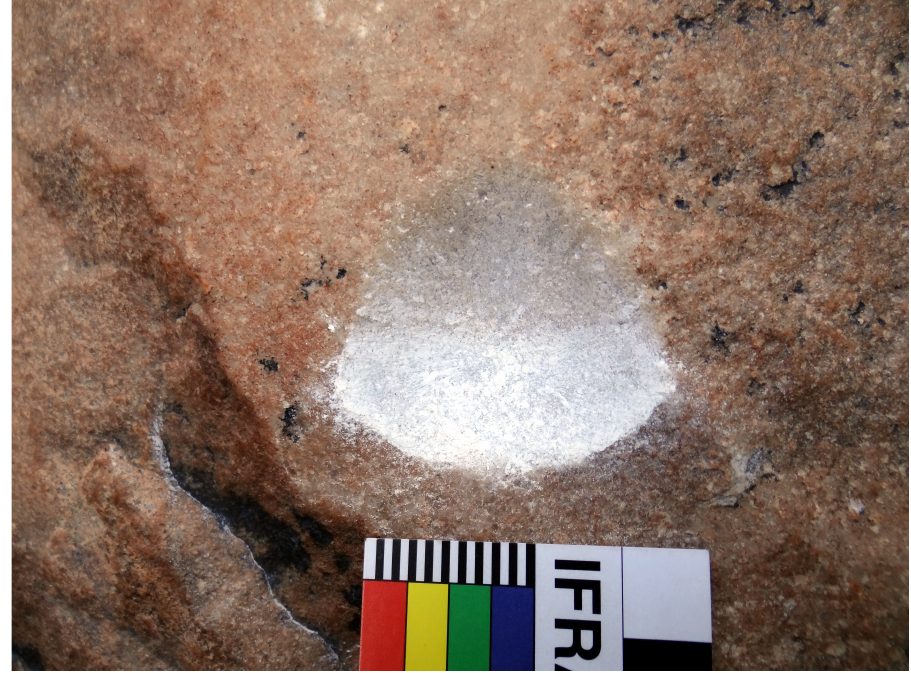
Figure 16. Replicated small cupule RC-10, with roughly triangular shape and depth.